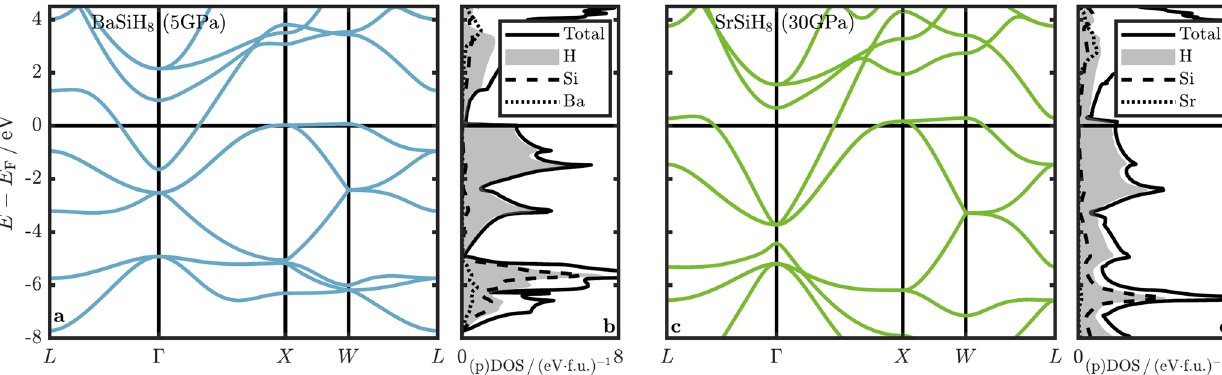
Fig. 3 Electronic band structure and density of states. a Electronic band structure of BaSiH 8 at 5 GPa and b corresponding total DOS (solid black) and projected H DOS ( fi lled blue). Panels c and d as a and b but for SrSiH 8 at 30